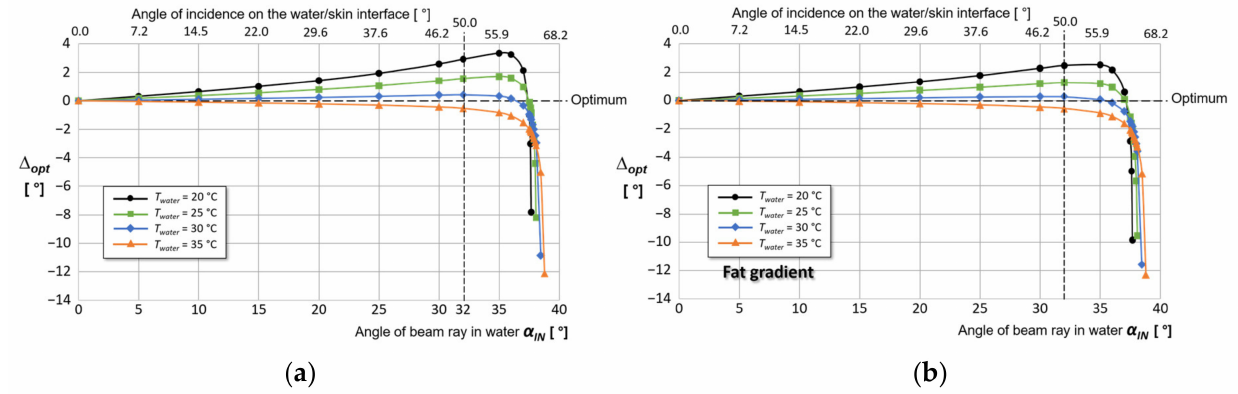
Figure 11. Results of the calculation of the parameter ∆ opt as a function of the angle α IN for different values of the water temperature and both models: without ( a ) and with temperature gradient ( b ) in the fat